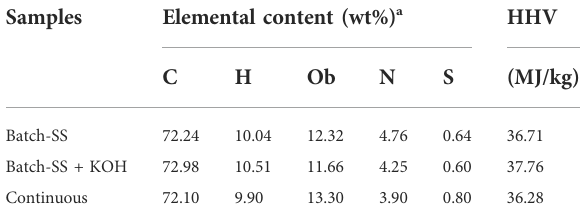
TABLE 6 Comparison of elemental composition and higher heating valuesinthebiocrudeobtainedfrombatchandcontinuousHTLof sludge at 350 ° C with 8 min retention time.